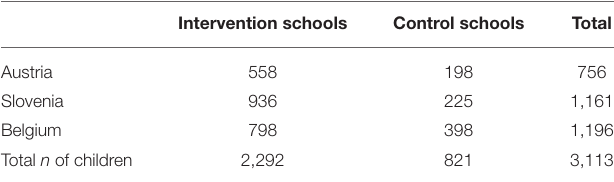
TABLE 2 | Estimated sample size for